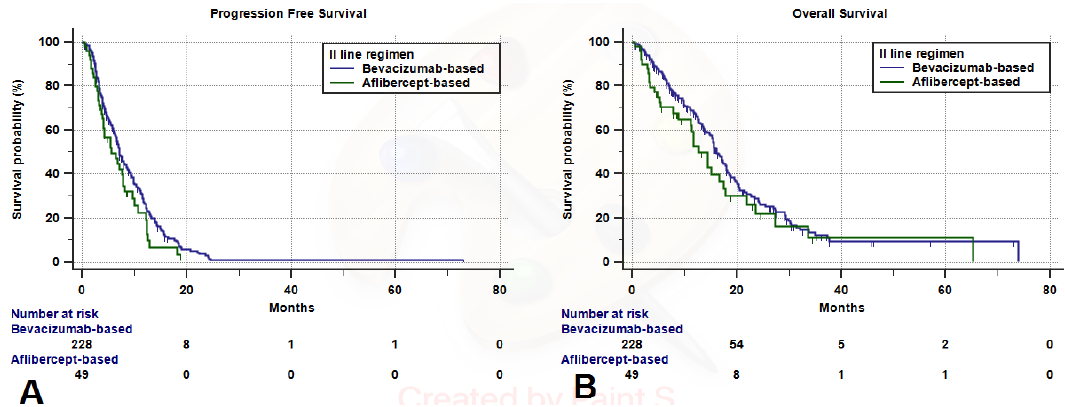
Figure 1. Kaplan – Meyer PFS ( A ) and OS ( B ) curves according to the second-line regimen. Figure 1. Kaplan–Meyer PFS ( A ) and OS ( B ) curves according to the second-line regimen. Table 3. Univariate and multivariate analysis for progression-free survival. Table 3. Univariate and multivariate analysis for progression-free survival.